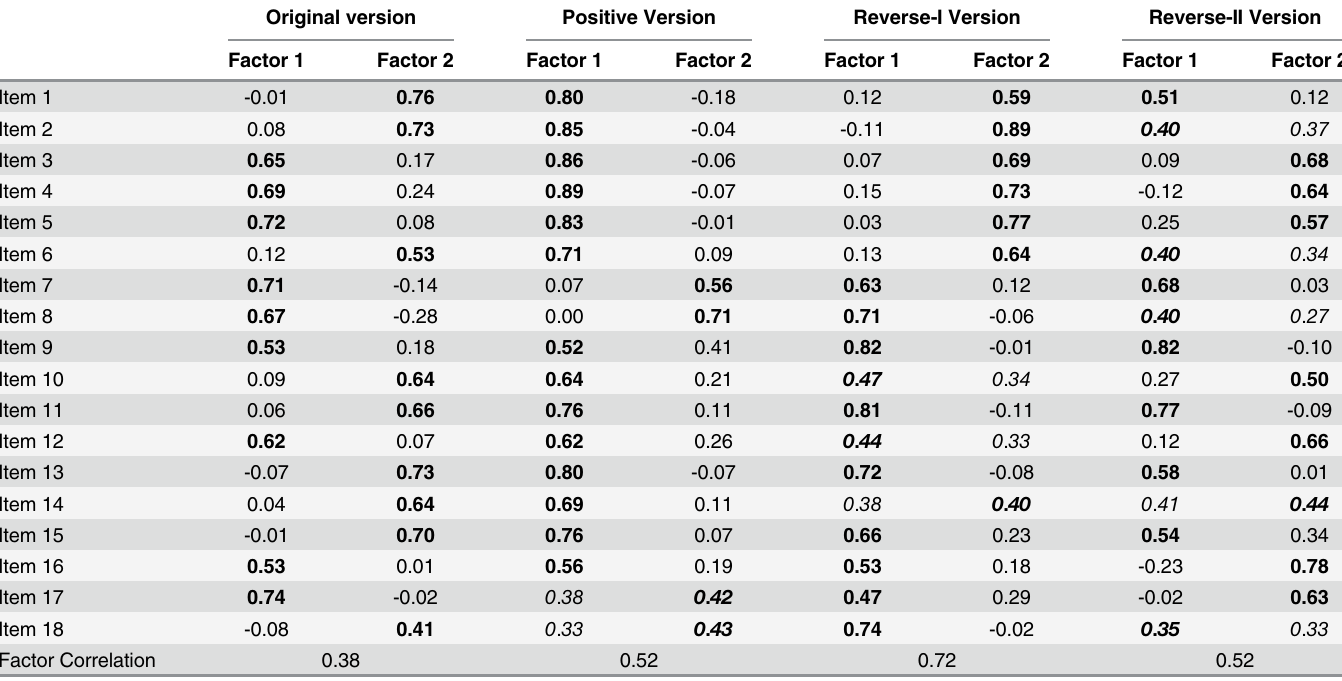
Table 3. Standardized Factor Loadings of Model 2 for the Four Scale